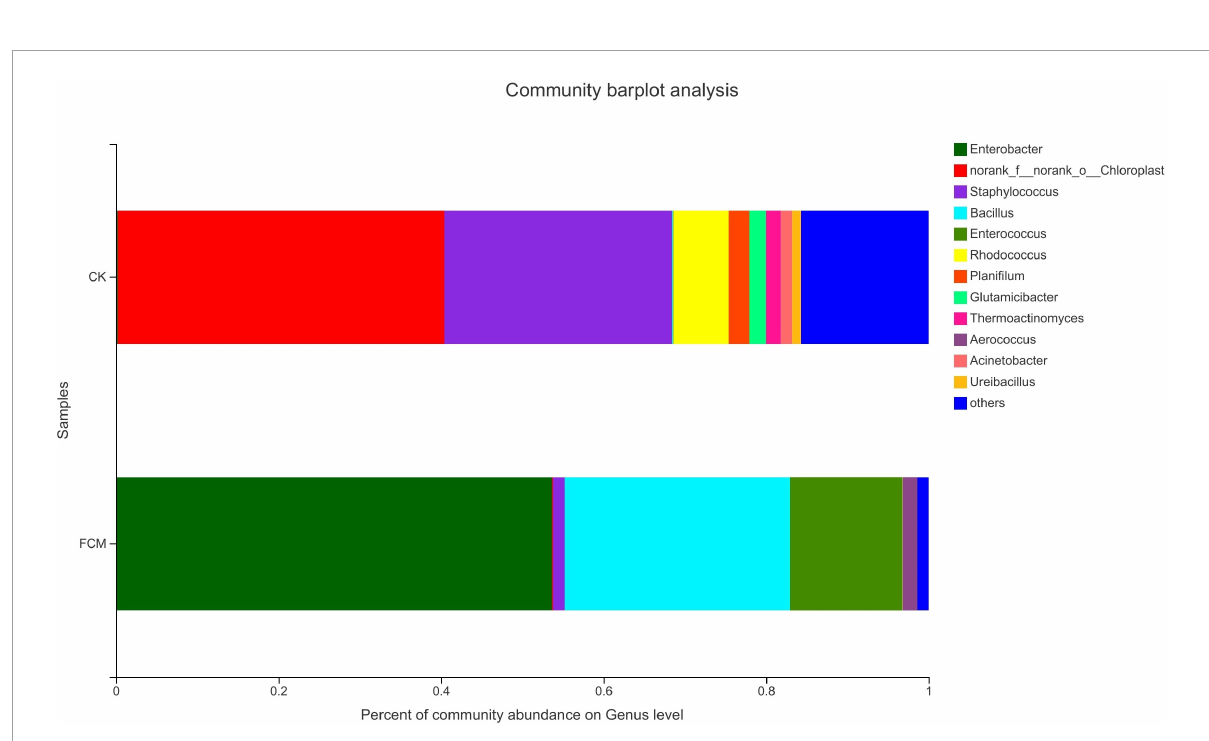
FIGURE8 Column diagram of bacterial community at genus level. The abundance is represented in terms of the percentage of the total effective bacterial sequences in the sample [CK: cottonseed meal (CM); fermented cottonseed meal (FCM):